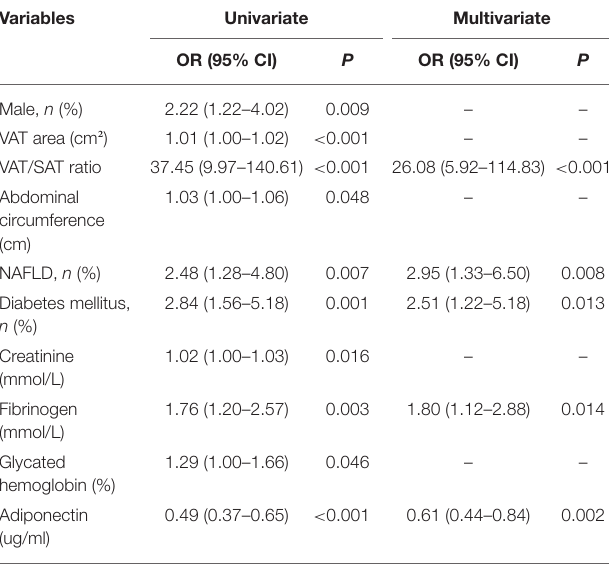
TABLE 2 | Univariate and multivariate analysis of the risk factors for ICAS.